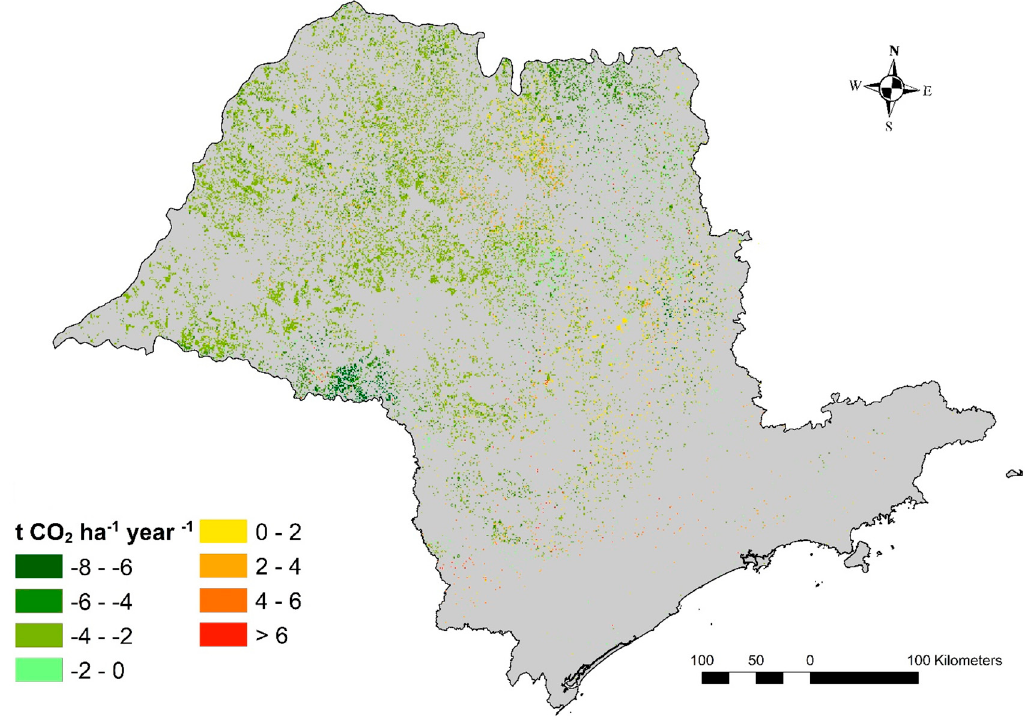
Figure 2. Annual LUC-related CO 2 emissions from sugarcane expansion between 2005 and 2015, considering an amortization period of 20 years. Negative values represent carbon accumulation.